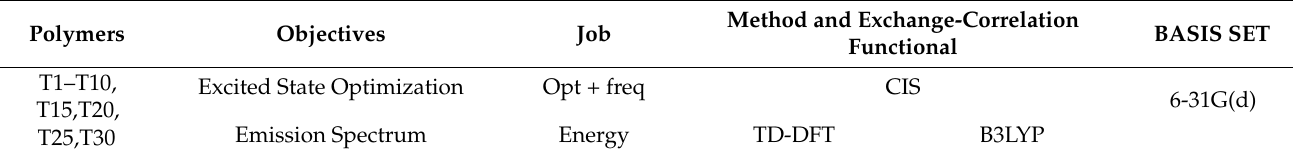
Table 2. Calculation method, exchange–correlation functional, and basis set used in Gaussian 09 for calculation of excited state of 1. T10, T15, T20, T25, and T30.